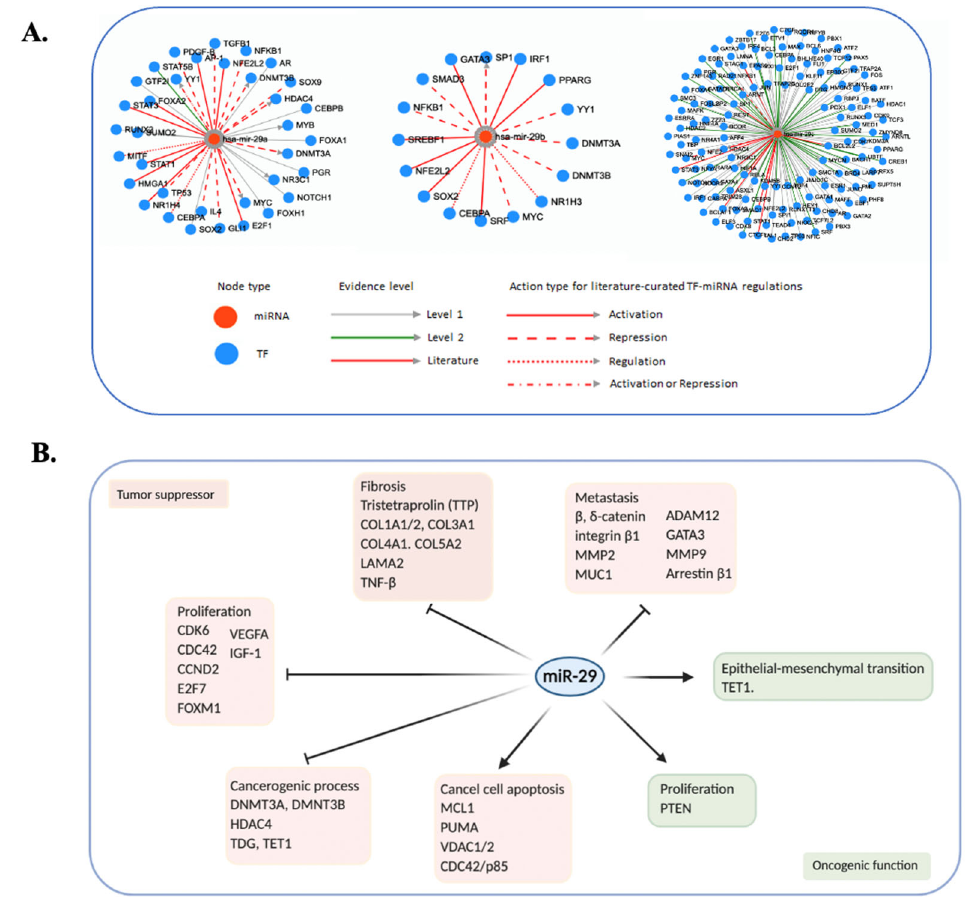
Figure 2. Roles of miR-29s in human cancers. ( A ) MiR-29s modulated different transcription factors. The visualization is based on miR-29s in transcriptome networks of the TransmiR v2.0 platform (cuilab/cn/transmir). The red dots represent has-mir-29a, -29b, and -29c from left to right, respectively, while the blue dots represent different cancer-related transcription factors. ( B ) cancer-related miR-29s targets. MiR-29s can act as both tumor suppressor and tumor inducer genes by contributing to different cancer pathways such as cancer cell apoptosis, cancerogenic process, proliferation, fibrosis, and metastasis.